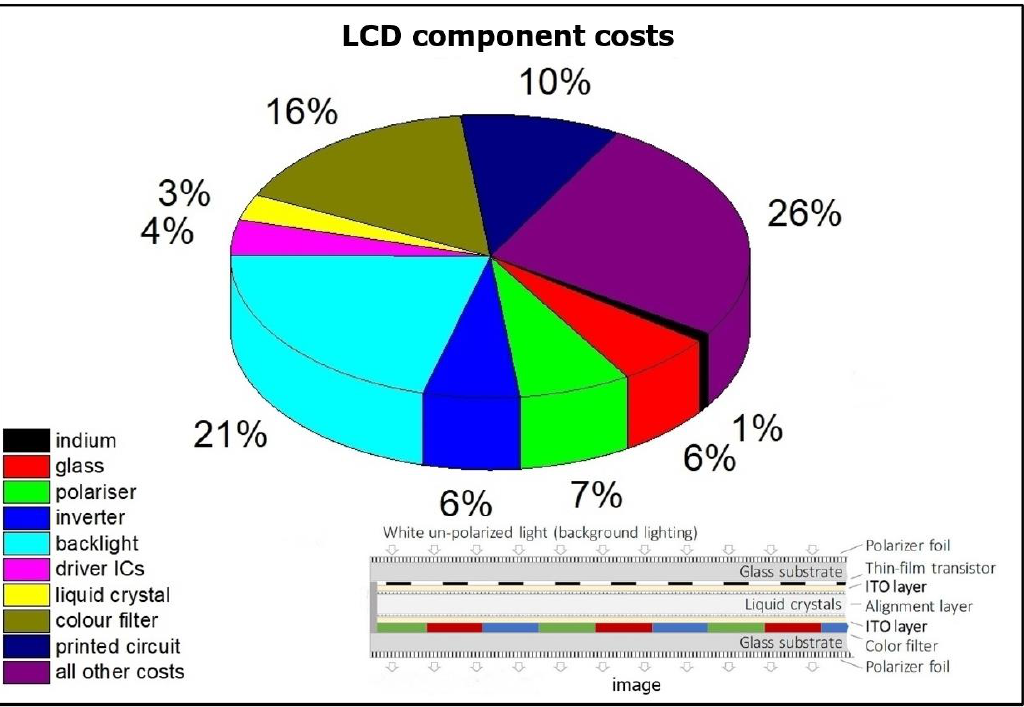
Figure 2. Cost of the components of a liquid crystal display (LCD). The inset depicts the actual construction of a standard sandwich cell for display devices. [Reproduced by permission after [8]].